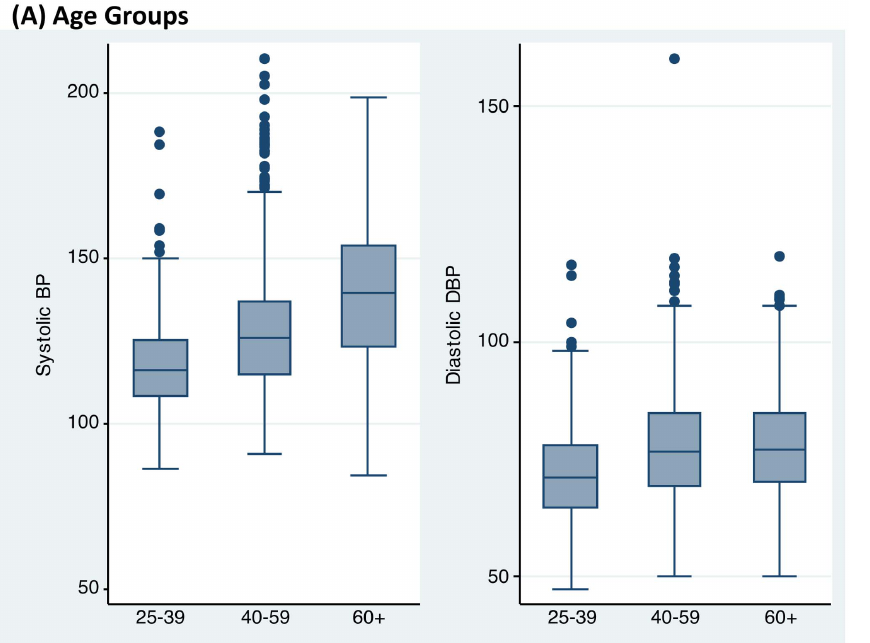
Figure 2. Distribution of Participant’s Blood Pressure according to Selected Characteristics. Shown was distribution of systolic and diastolic of blood pressure according to selected participant’s characteristics including age (Fig. 2A), sex (Fig. 2B), BMI categories (Fig. 2C), resident location (Fig. 2D), and educational level (Fig. 2E).